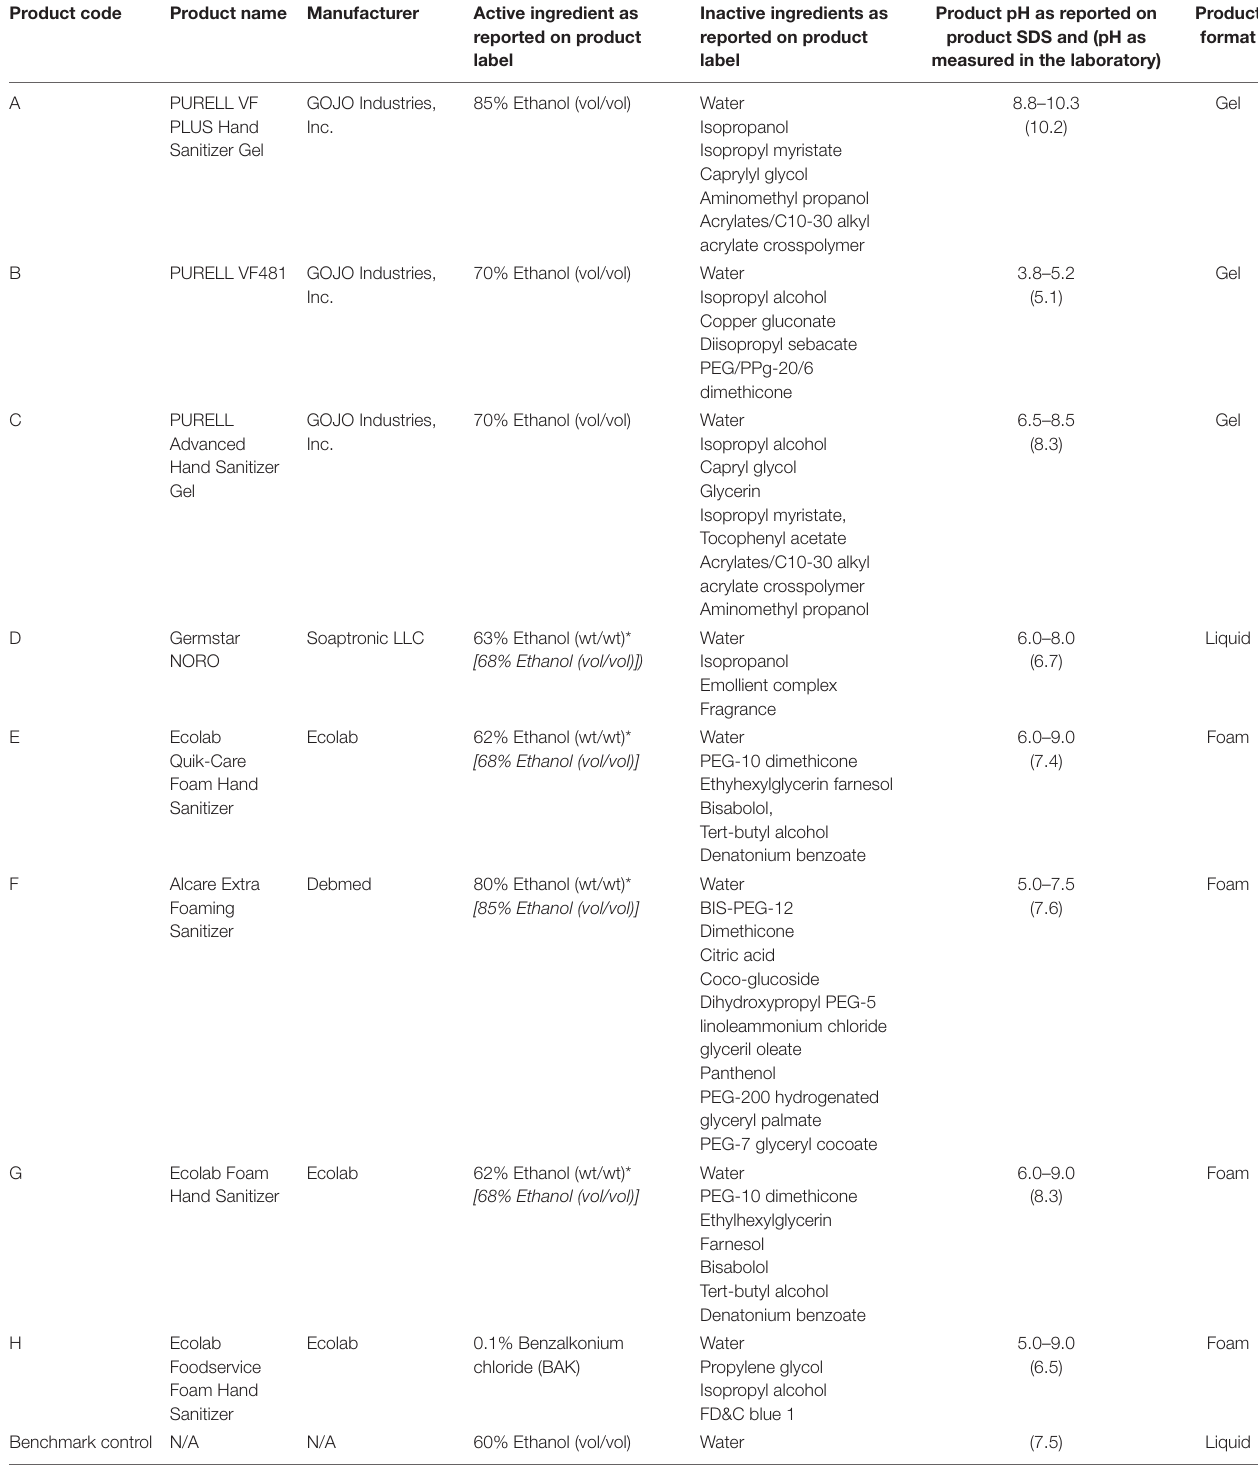
TABLE 1 | Commercial hand sanitizers evaluated in this study and their ingredients, format, and primary industry of application. Product